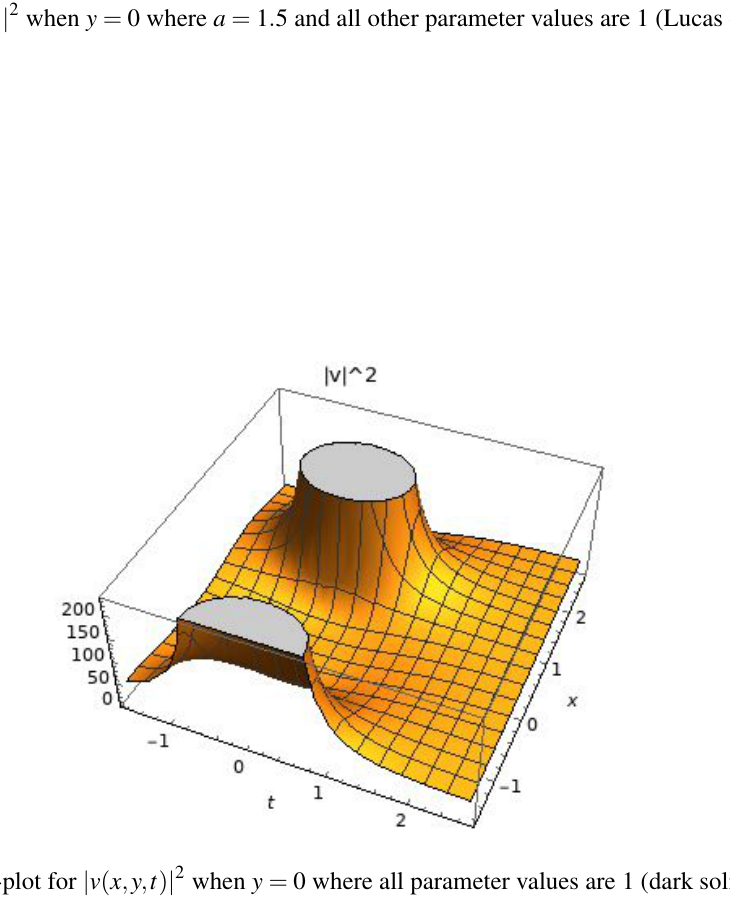
Fig. 5 3D-plot for | v ( x , y , t ) | 2 when y = 0 where all parameter values are 1 (dark